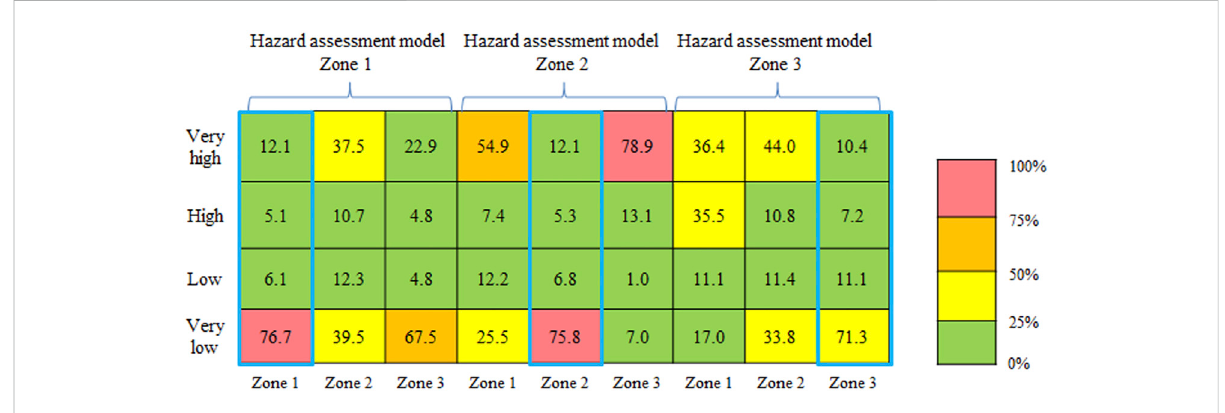
FIGURE 11 Proportion of landslide hazard levels in different